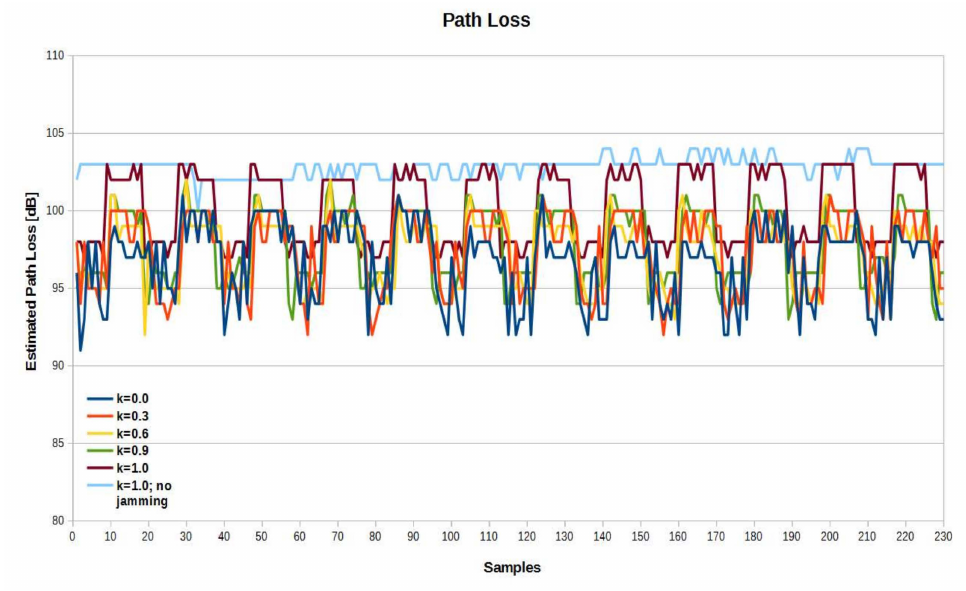
Figure 20. Path loss values with 30dB RF attenuator in the effector antenna